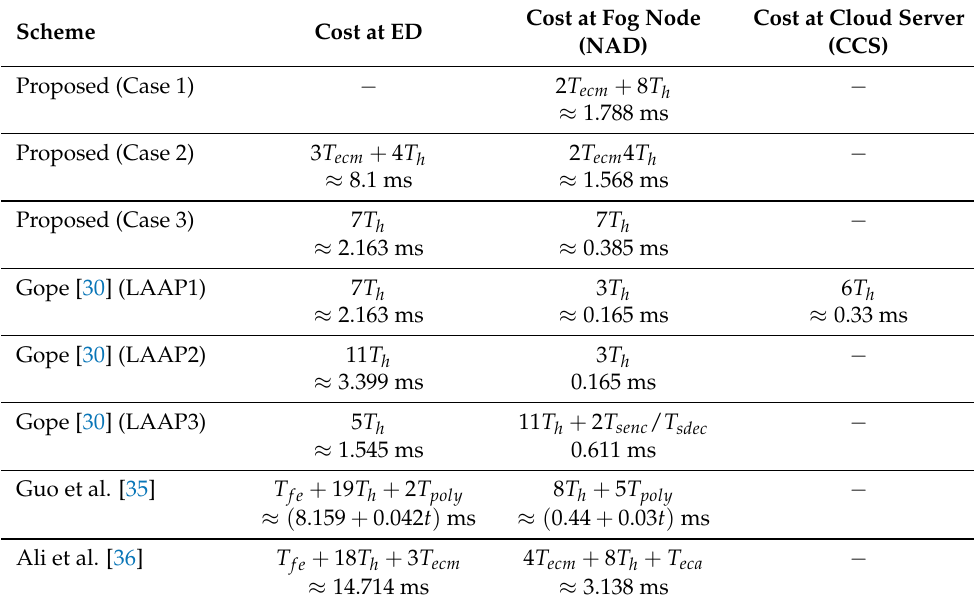
Table 4. Computation costs